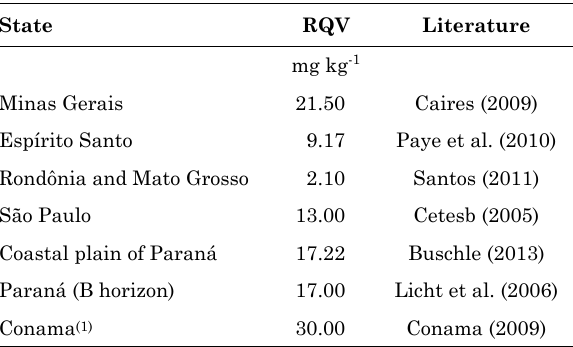
Table 4. Reference quality values (RQV) for nickel Table 5. Nickel concentration in plant tissues